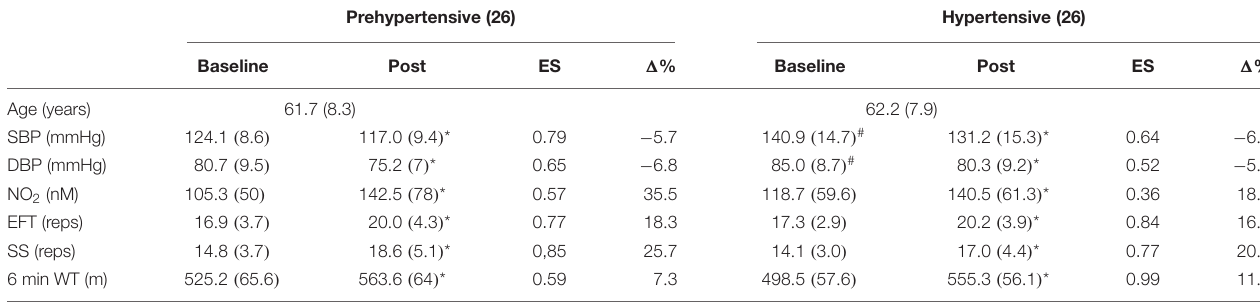
TABLE 2 | Effects of multicomponent training on blood pressure, nitrite concentration, and physical fitness in 26 prehypertensive and 26 hypertensive older adult women. Prehypertensive (26) Hypertensive (26)